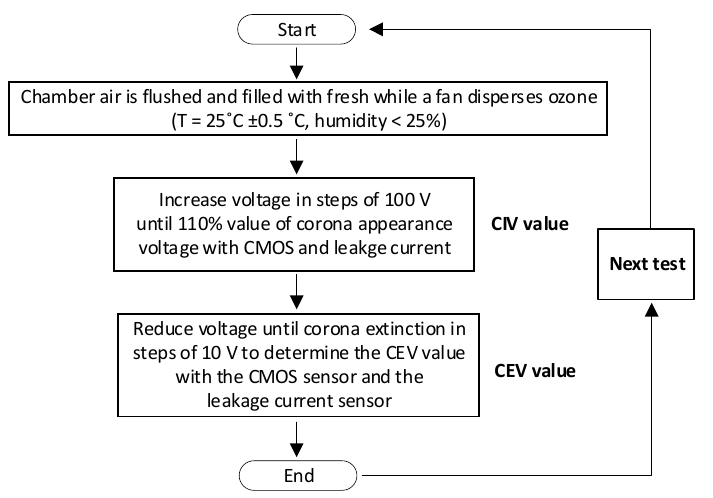
Figure 3. Procedure to determine the value of the corona extinction voltage (CEV). To avoid the CEV value to be influenced by ozone formation, the atmospheric air in the low-pressure chamber was completely replaced in each